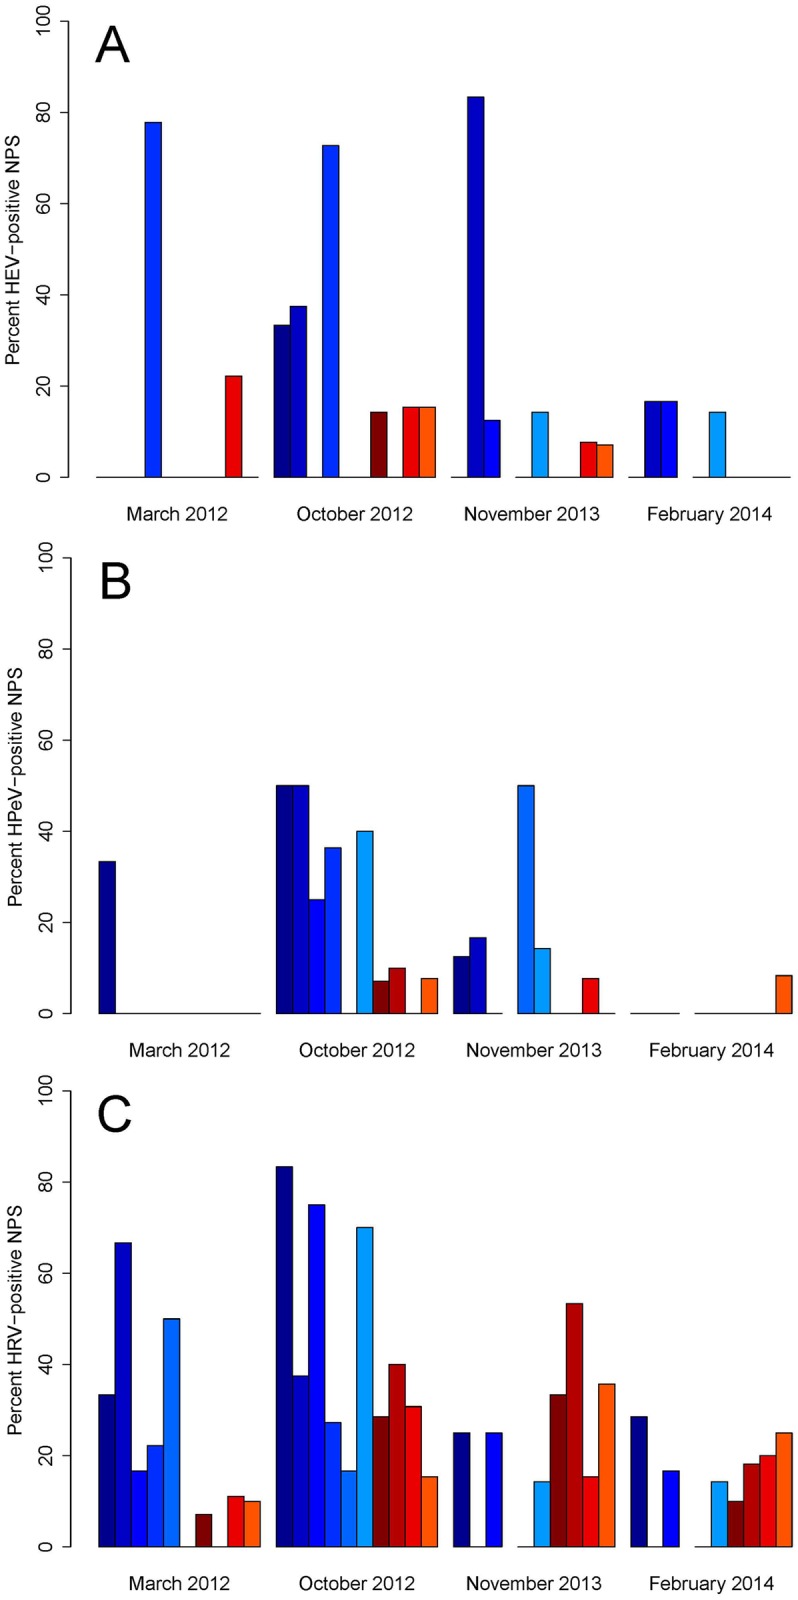
Occurrence of picornaviruses.Percent positive nasopharyngeal samples (NPS) for human enterovirus (HEV) (A), human parechovirus (HPeV) (B) and human rhinovirus (HRV) (C) at four different study visits (sampling times) and in each of 10 day-care sections, six young children sections (blue colors) and four older children sections (red colors). One of the young children sections was not sampled in November 2013 and February 2014.